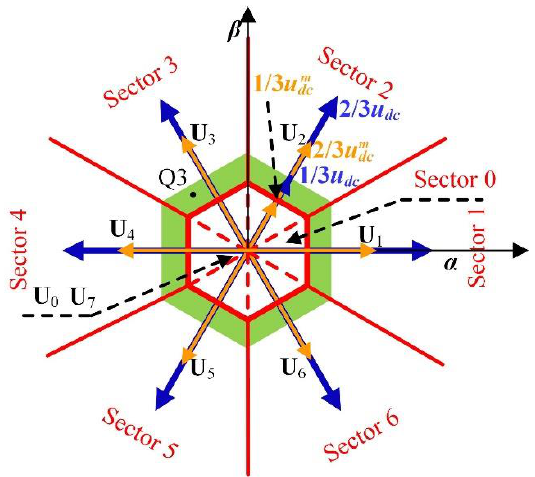
Figure 3. Distribution of reference voltage vector with under-voltage measurement.